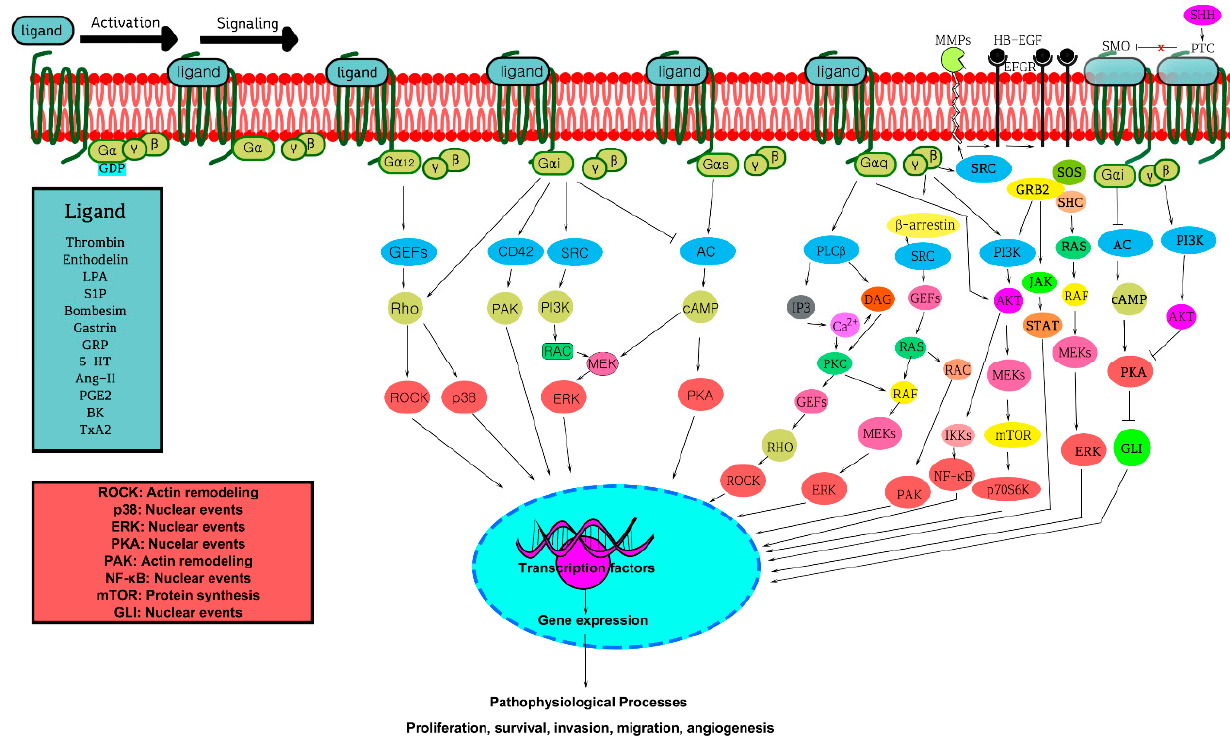
Figure 1. GPCR-mediated cell signaling pathways associated with cancer. Upon ligand binding, GPCR activates several downstream signaling pathways, including secondary such as GEFs for Rho, MAPKs, PI3Ks, along with their numerous cytosolic and nuclear targets. These receptor-mediated signaling cascades initiate various pathophysiological processes such as cell growth, survival, differentiation, tumor cell initiation, progression, and metastasis. Refer to the text for a detailed mechanism. Apdated from Lappano et al. [21].